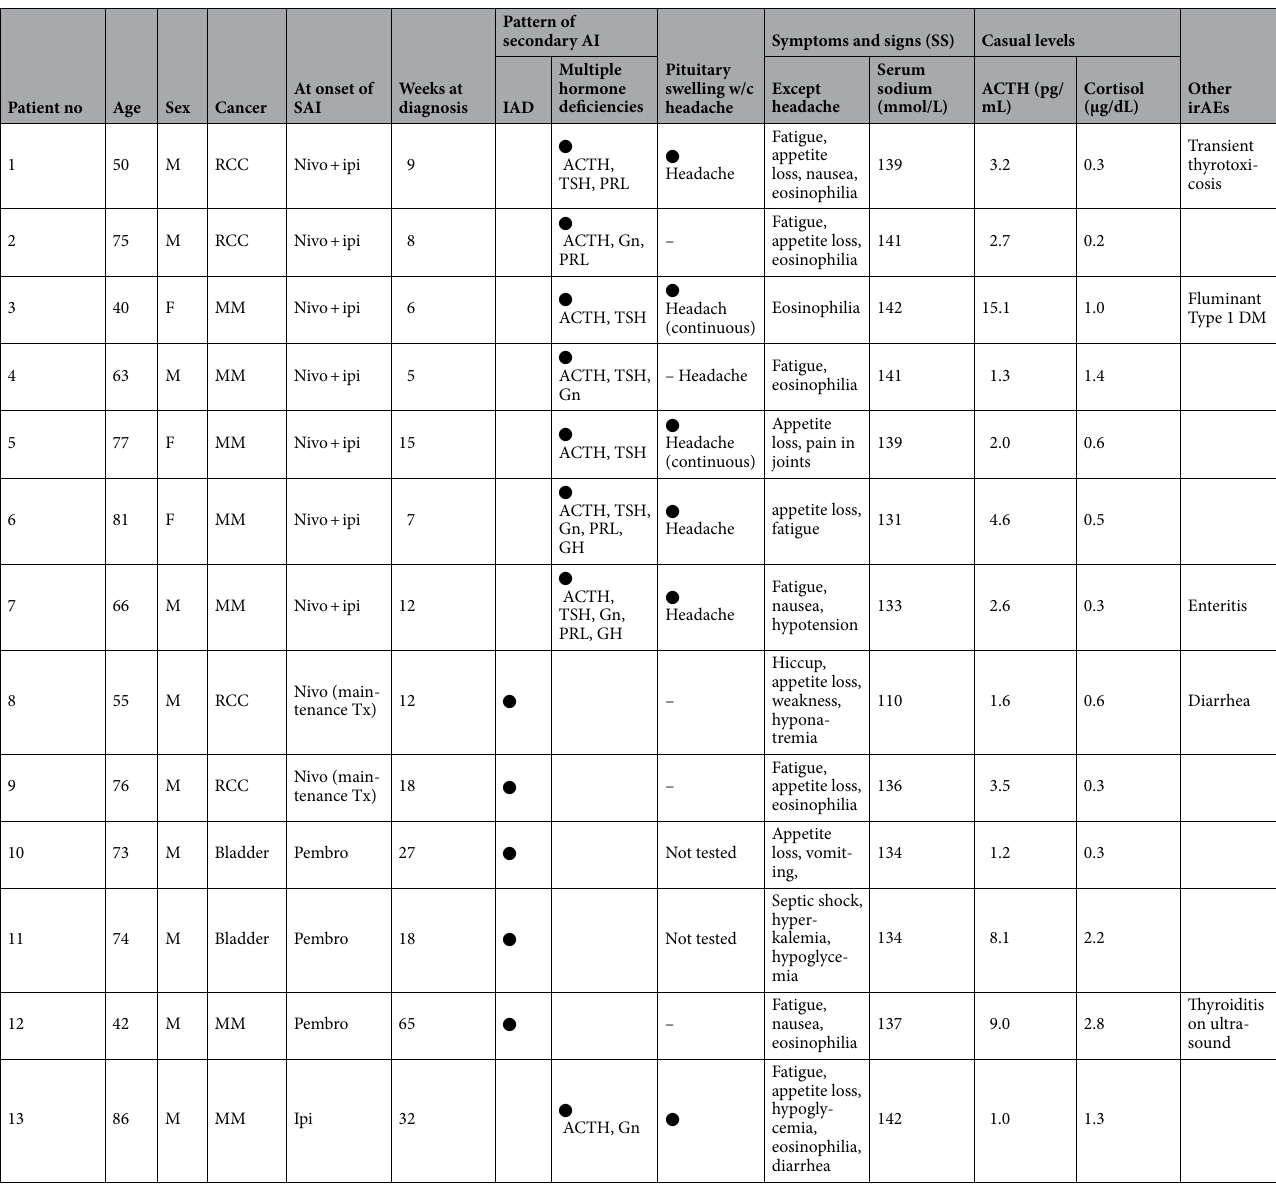
Table 3. Detailed clinical profiles of the patients with ICI-induced secondary AI. Four patients (No 3–6) were diagnosed their SAI based on the results of regular ACTH and cortisol tests. A TSH deficiency was diagnosed based on TSH, fT4, and/or a thyrotropin-releasing hormone (TRH) loading test. ACTH, adrenocorticotropic hormone; TSH, thyroid stimulating hormone; Gn, gonadotropin; PRL, prolactin; GH, growth hormone; M, male; F, female; RCC, renal cell carcinoma; MM, malignant melanoma; Bladder, bladder carcinoma; combination, combination therapy of ipilimumab and nivolumab; nivo, nivolumab; pembro, pembrolizumab; ipi, ipilimumab; cs, courses; IAD, Isolated ACTH deficiency; SAI, secondary adrenal insufficiency; SS, symptoms and signs; DM, diabetes